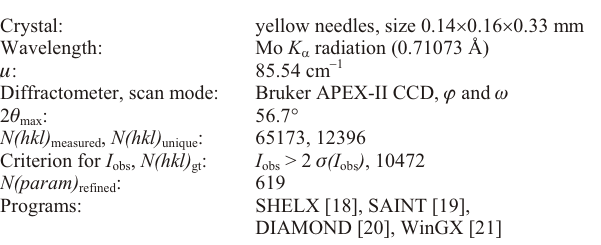
Table 1. Data collection and